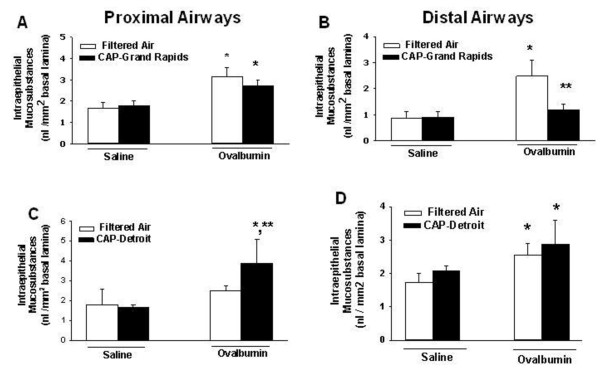
Effect of CAPs exposure on intraepithelial mucosubstances (IM). Animals were sensitized and challenged with saline (white bars) or with OVA (black bars) immediately prior to exposure to CAPs in Grand Rapids (A, B), or Detroit (C, D). Twenty four hours after the CAPs exposure lungs were processed and stained with AB/PAS and intraepithelial mucus was quantified in proximal (A, C) and distal (B, D) conducting axial airways as described in Methods. * = significantly different from respective group challenged with saline; ** = significantly different from respective group exposed to filtered air; n = 8/group; p < 0.05.